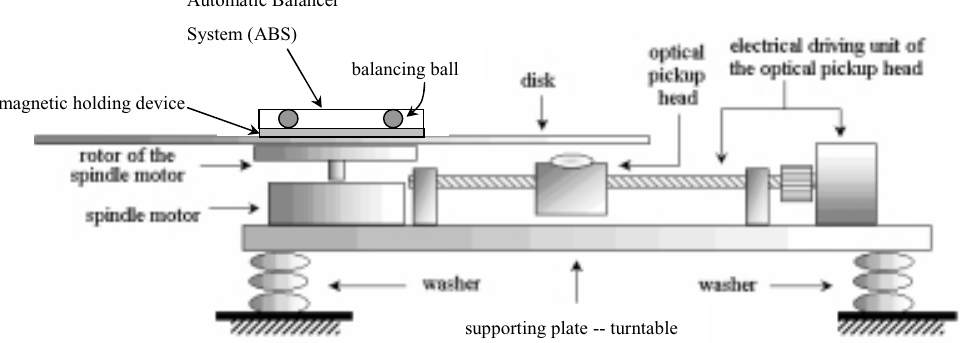
Fig. 1. Schematic of the optical pickup assembly including rotating and non-rotating